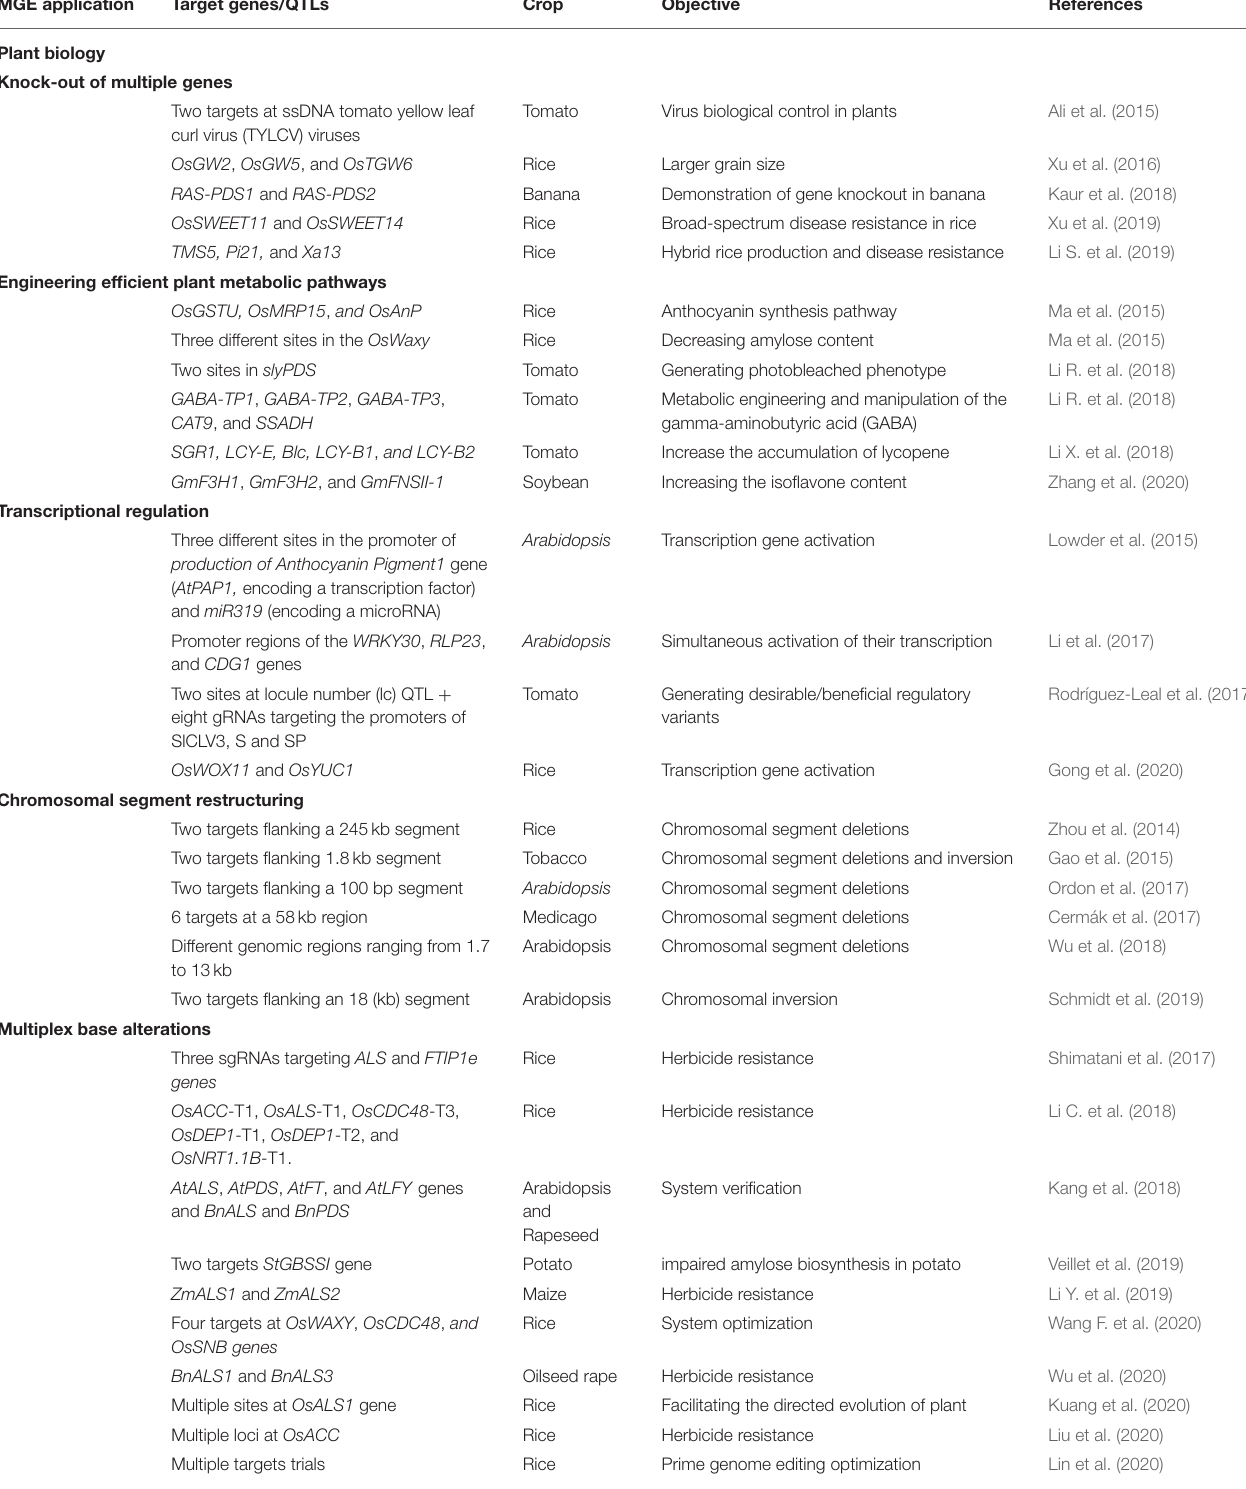
TABLE 1 | Summary presentation of the efforts done using multiplex genome editing for revolutionizing plant biology and crop improvement